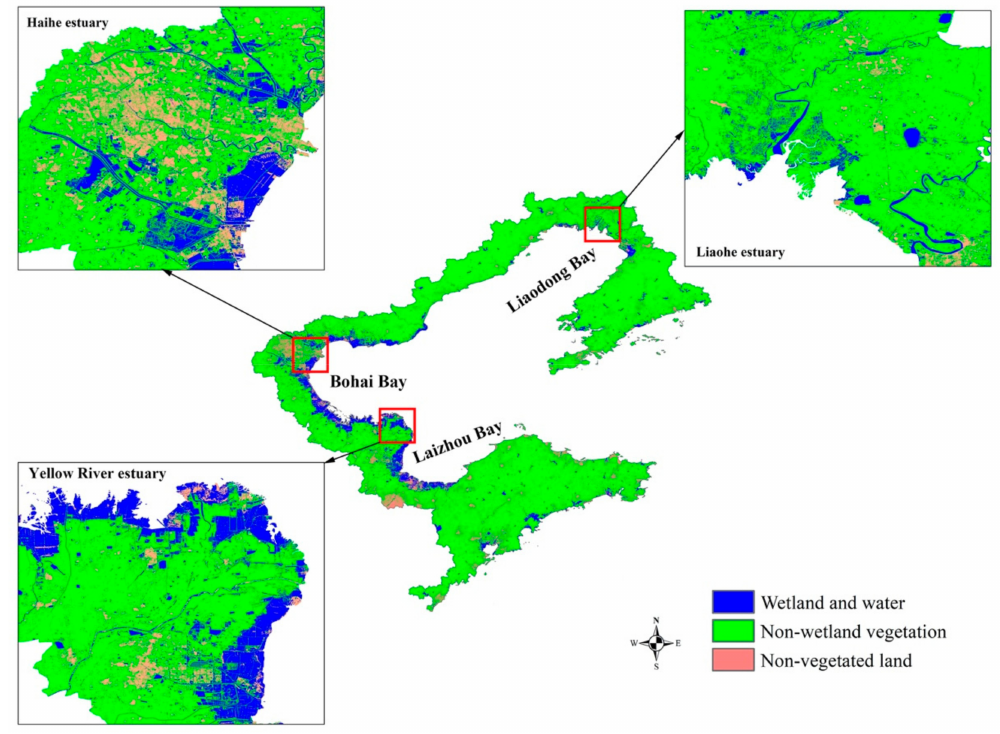
Figure 5. The Bohai Rim coastal wetland map predicted by the OST model